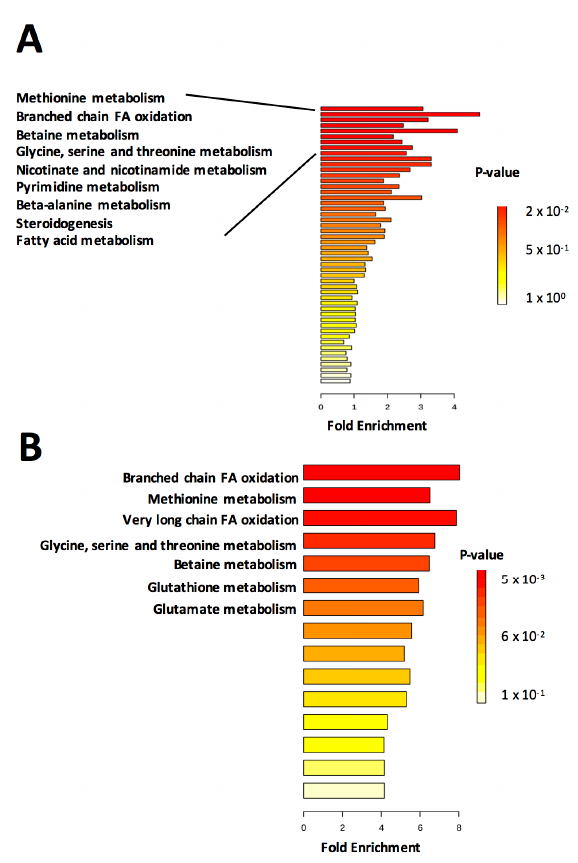
Figure 2. Metabolite set enrichment analysis reveals metabolic pathways enriched in livers of FLT mice. Enrichment analysis was performed in MetaboAnalyst using ( A ) all metabolites or ( B ) only metabolites with significantly changing abundances between groups ( p < 0.05). n = 5/group. Eighty-eight metabolite sets based on “normal metabolic pathways” were used for the analysis. For clarity of presentation, only the most significantly enriched metabolite sets are annotated.